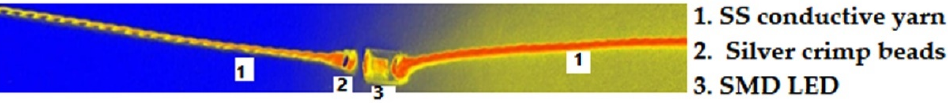
Figure 11. Breakage at connection point between the SMD LED and silver crimp